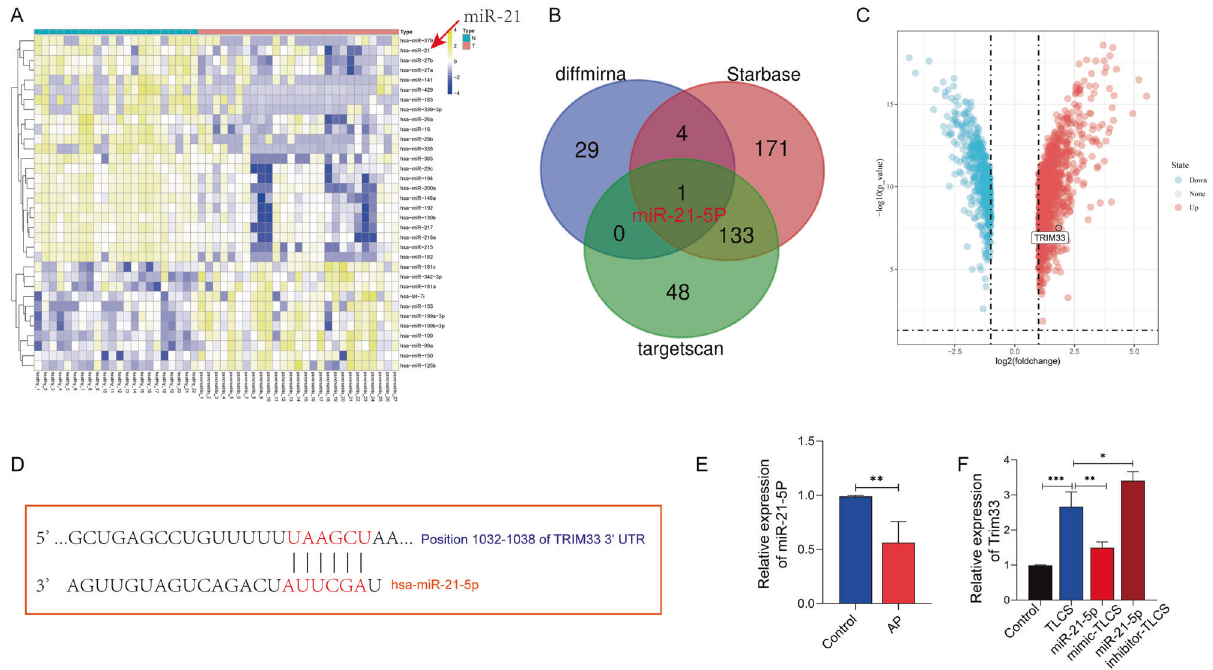
Fig. 6 miR-21-5p can inhibit the expression of Trim33. A miRNA difference analysis; B starBase and TargetScan predicted that miRNA may bind to Trim33; C analyzing the mRNA difference between human AP tissue and normal tissue; D the binding site of miR-21-5p and Trim33; E the expression of miR-21-5p in the AP group was signi fi cantly lower than that in the control group; F miR-21-5p was overexpressed and knocked down in AR42J cells and treated with TLCS, and then the mRNA and protein levels of Trim33 were observed ( t -test, *** p < 0.001, ** p < 0.01, * p <